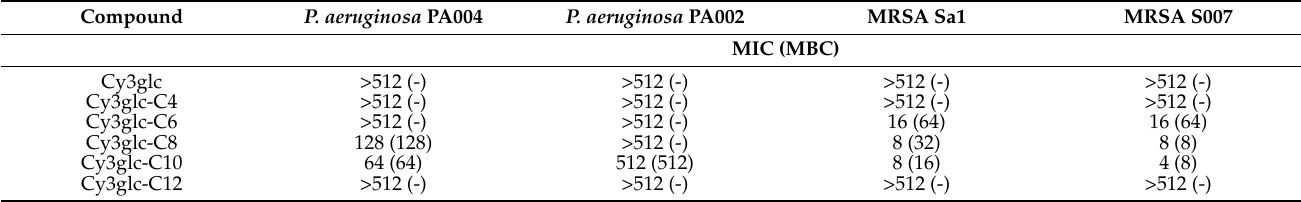
Table 2. Minimum inhibitory concentrations (MICs) and minimum bactericidal concentration (MBCs), in µ g/mL of compounds against two multidrug-resistant P. aeruginosa isolates and two methicillin-resistant S. aureus (MRSA).